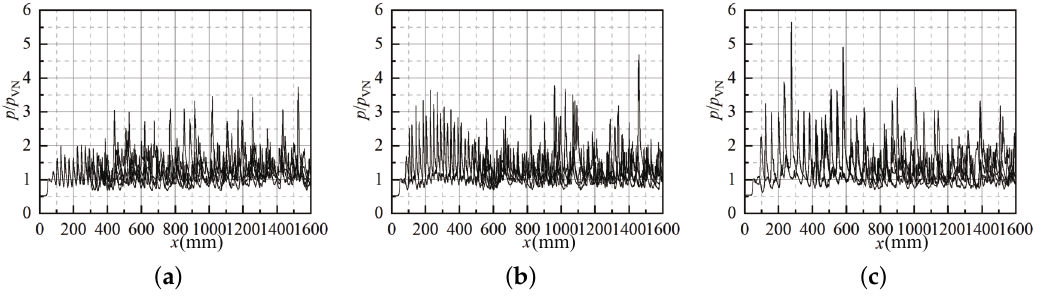
Figure 11. Pressure history for cases with different artificial perturbations at k R = 4 s − 1 , ( a ) s = 10 ∆ I , ( b ) s = 20 ∆ I , and ( c ) s = 40 ∆ I .